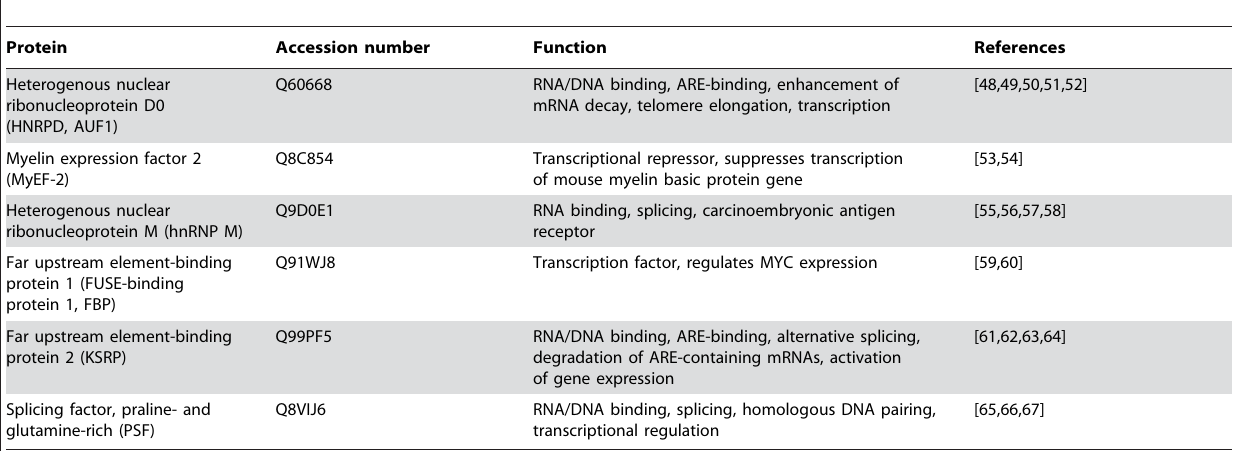
Table 1. List of proteins that were found to be interacting with the 3’terminal part of the EphA2 3’UTR and their most important functions.